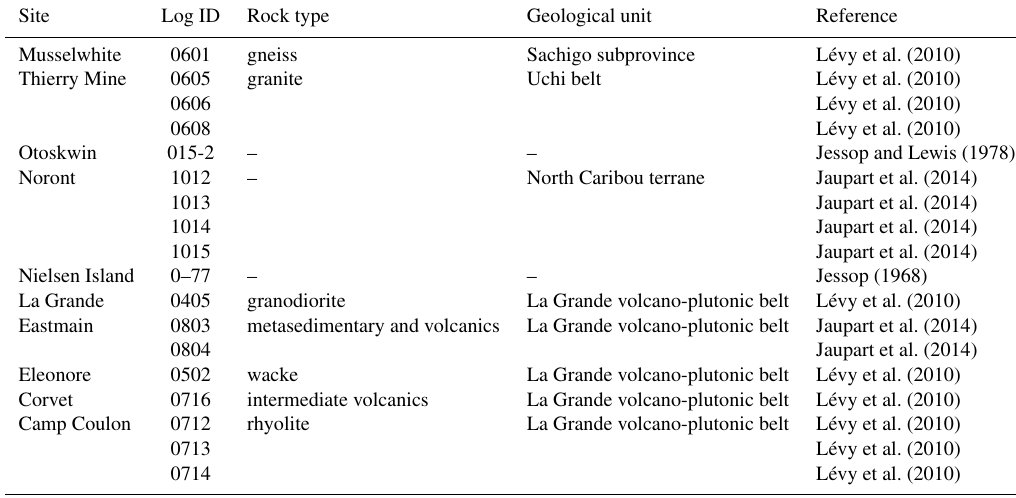
Table A1. Geological unit and rock type concerning the boreholes used in this